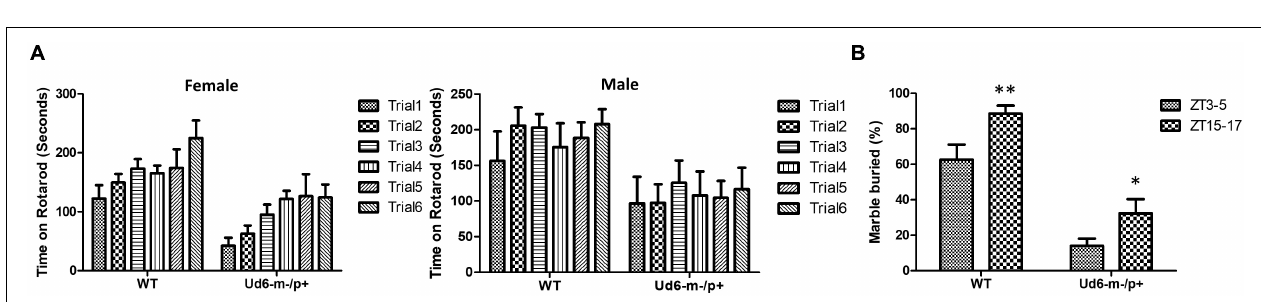
FIGURE 3 | Reduced abundance of UBE3A-positive neurons in Ud6-m-/p+ SCN. (A) Representative IHC images of SCN sections from wild type (WT; left) and Ud6-m-/p+ (Ud6; right) brains. The UBE3A-immunopositive cells (brown dots) are densely distributed throughout the SCN in WT, but are sparse in Ud6. Scale bar = 100 µ m. (B) Quantification of positively stained cells in the SCN. Data are expressed as the number of positive cells calculated in 3–9 separate sections per each brain, and the group mean ± SEM (individual mice numbered along the abscissa; numbers 1–3 for WT and 4–7 for Ud6-m-/p+). Black dots represent immunohistochemical diaminobenzidine staining (WT n = 2, Ud6-m-/p+ n = 3), while green dots represent data from immunofluorescence staining (WT n = 1, Ud6-m-/p+ n = 1; see Supplementary Figure 1 ). Error bars are SEM. (C) Combination of data from (B) depicting the relative UBE3A staining in all SCN sections where 100% is set as the mean of all WT values (WT n = 3, Ud6-m-/p+ n = 4). Error bars are SEM.